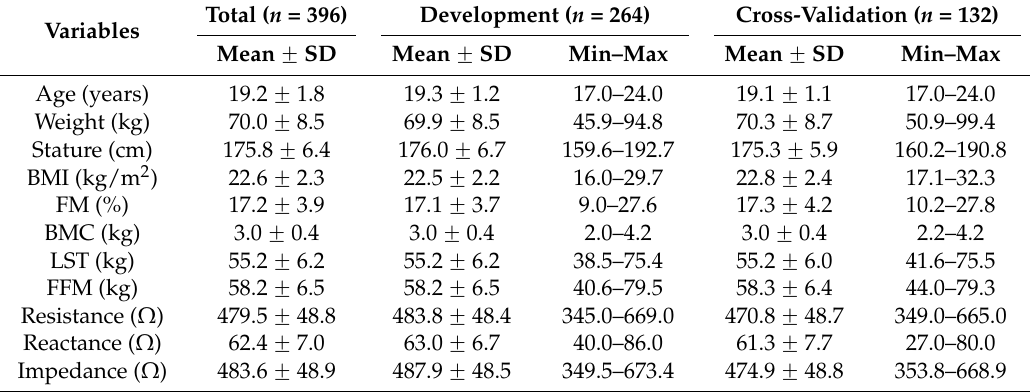
Table 2. Characteristics of the total sample and the groups (development and cross-validation) of specific BIA